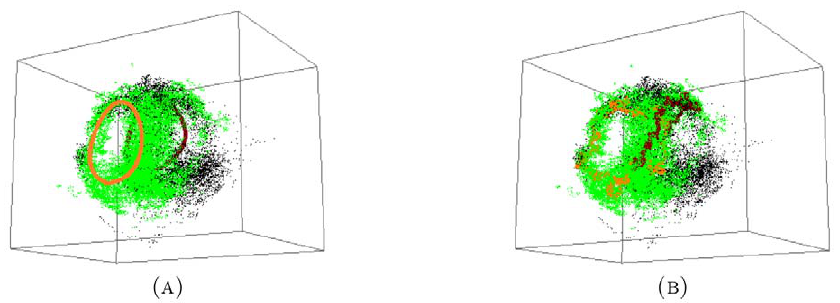
Figure 15. The persistant generators of the experimental data set long + distal are displayed. (A) long + distal with smooth represenative generators; and (B) long + distal with actual generators produced in